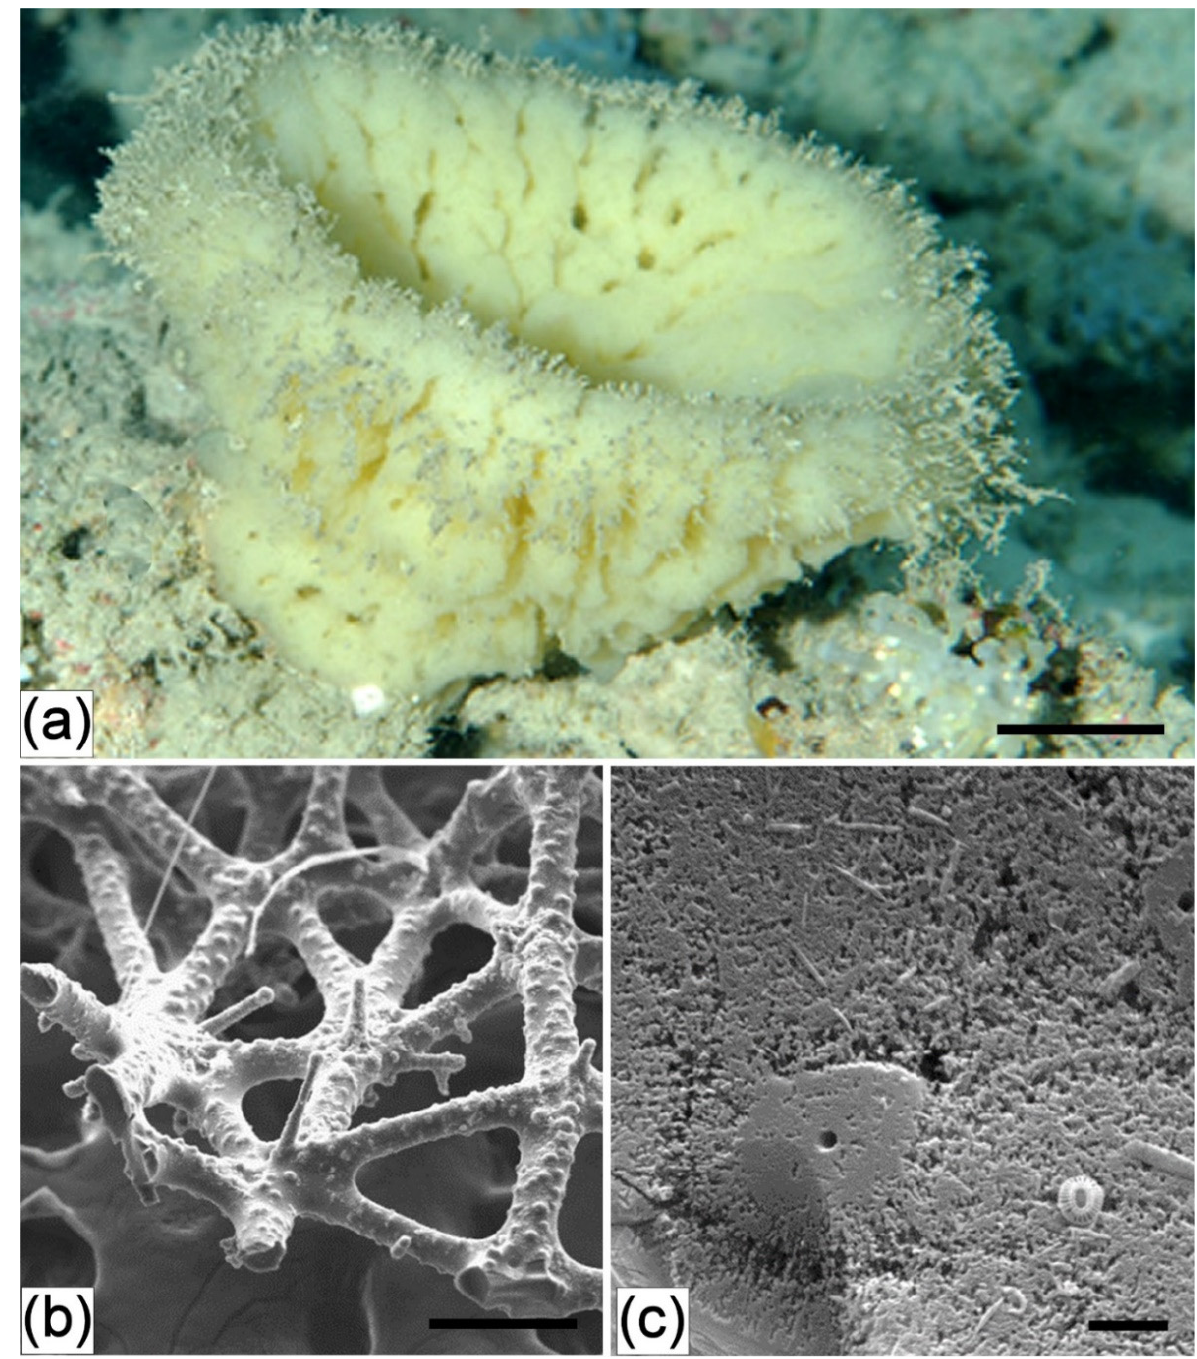
Figure 7. Dactylocalyx sp. Morphological feature ( a ) and the ultrastructure of the spicules by SEM ( b , c ). Scale: ( a )—2 cm, ( b )—200 μ , ( с )—4 μ .